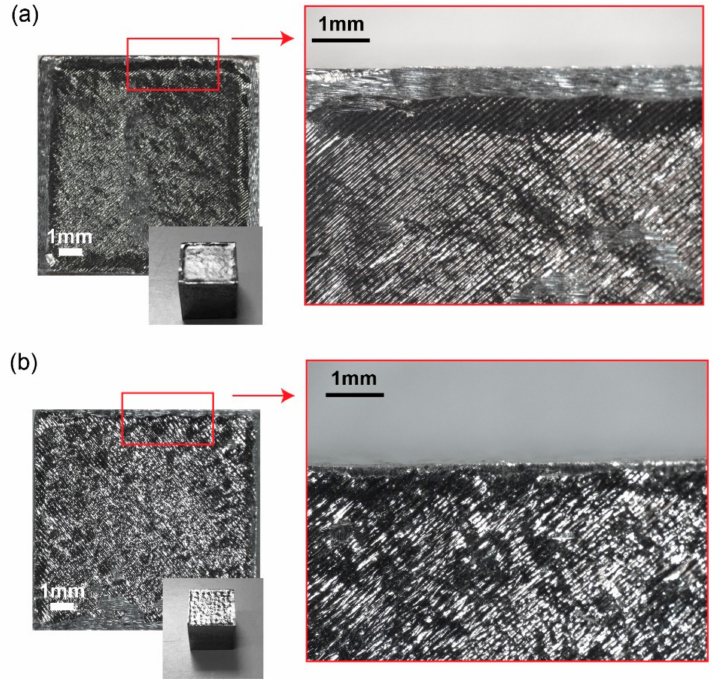
Figure 5. ( a ) Sample with inaccuracy on the up-skin surface: The sample has the contour raised above the internal area (up-skin); ( b ) sample without defect on the up-skin